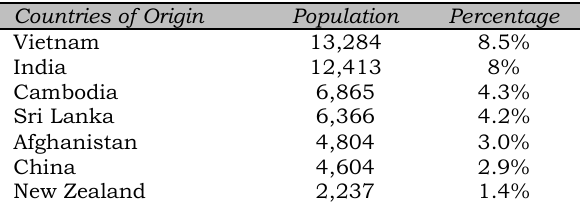
Table 1. Overseas-born Residents